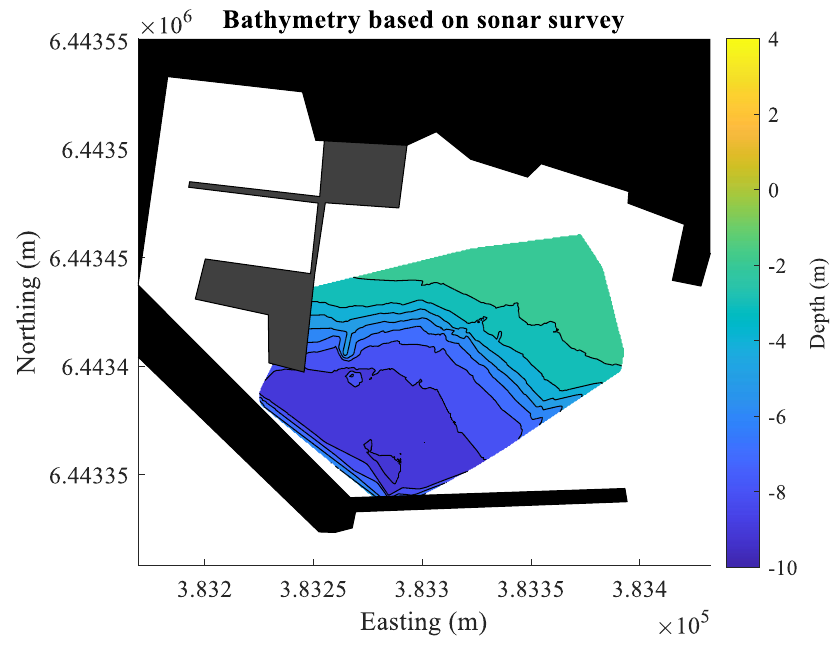
Figure 10. Bathymetry map of Northern Harbour generated from sonar data recorded during the surveys.